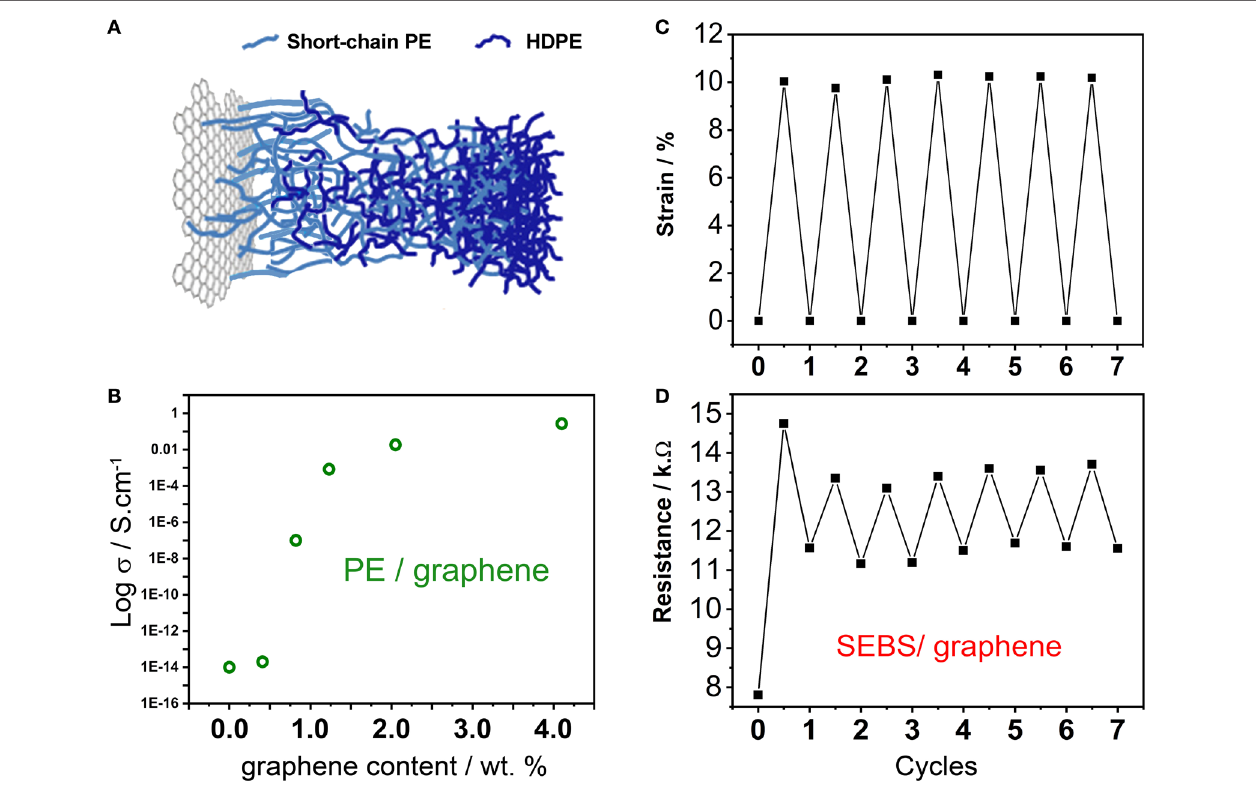
FiGUre 2 | The effect of the functionalization of graphene with polymer brushes on the properties of its nanocomposites. (A) Schematic representation of the polymer/graphene interphase for graphene modified with polymer brushes. (B) Electrical percolation of graphene/polyethylene nanocomposites (Castelaín et al., 2013a), reproduced by permission of The Royal Society of Chemistry. (c,D) Electromechanical behavior of nanocomposites of graphene with poly (styrene-b- ethylene-co-butylene-b-styrene) (SEBS). Reproduced from Enrique-Jimenez et al. (2017) with permission from